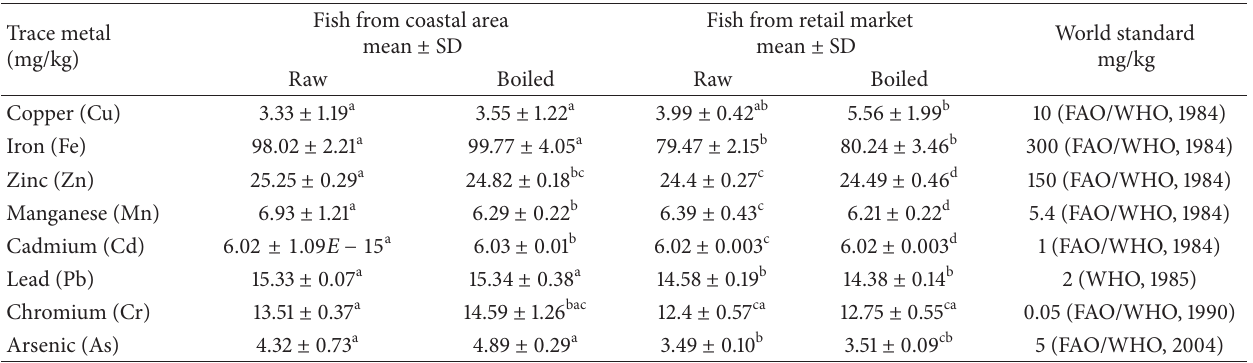
Table 2: Effects of sampling location and boiling on trace metal concentration (in mg/kg) in the silver pomfret fish